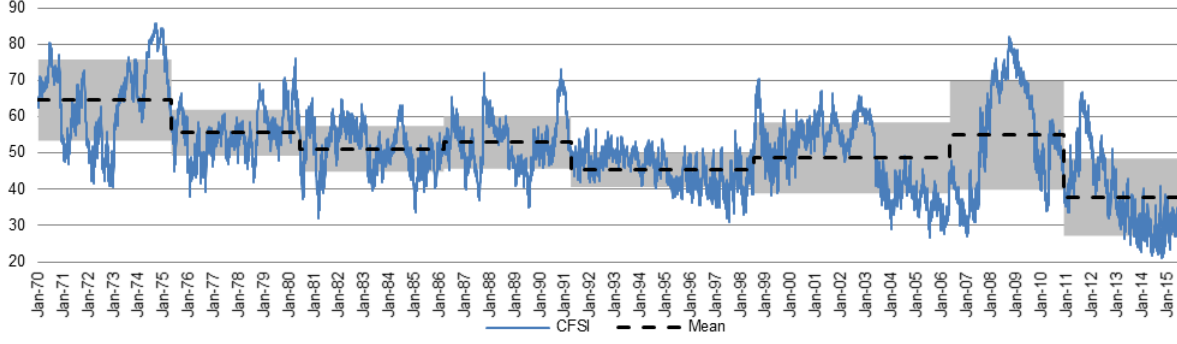
Figure 7. Daily CFSI compared to the mean and standard deviation (shaded region) of stress in each